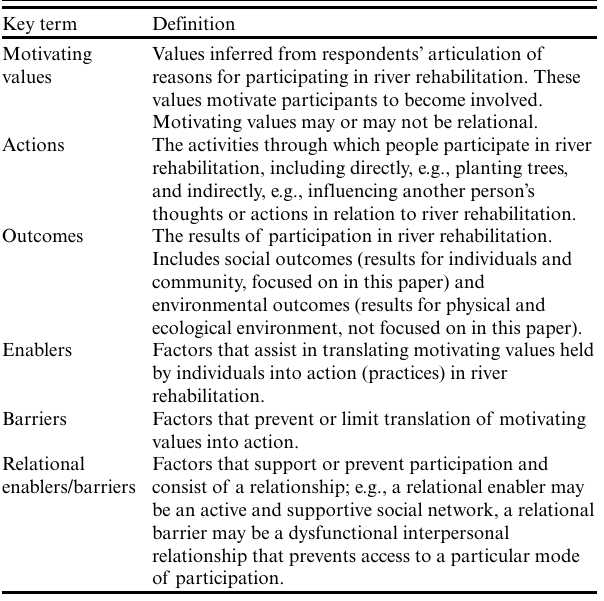
Table 2 . Definitions for key terms used in this paper. Fig. 1 . (a) Map of the Macdonald River showing town of St